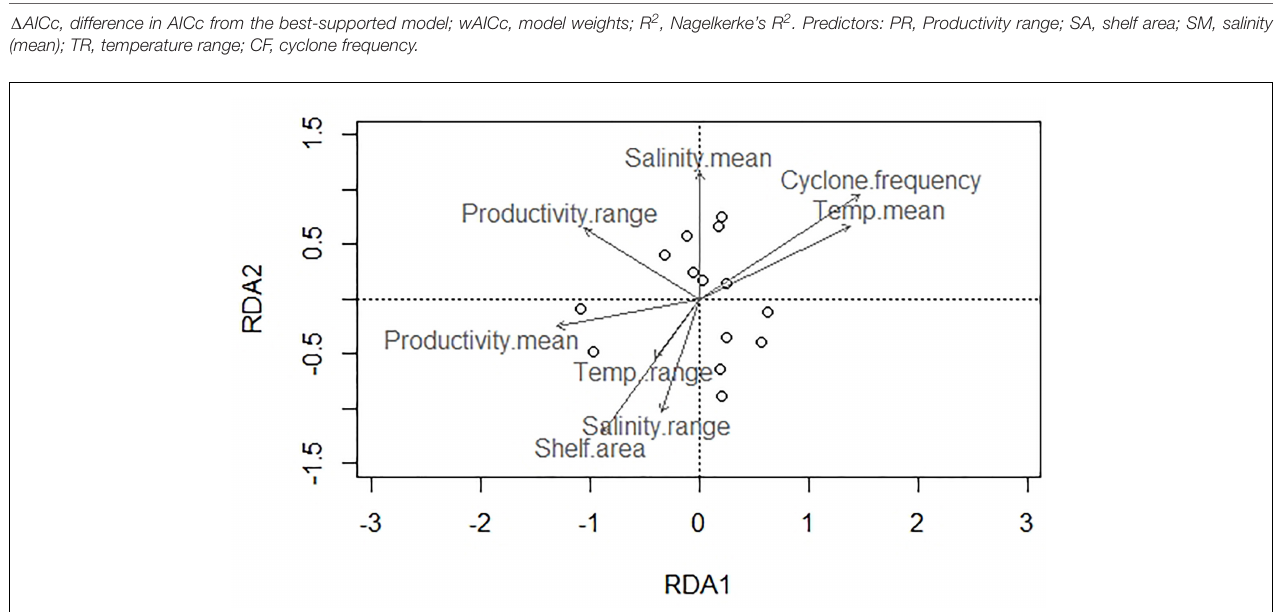
microstructure, with an exceptionally short lifespan, might be less represented in death assemblages due to differential post-mortem durability (Albano and Sabelli, 2011; Kidwell, 2013). High energy